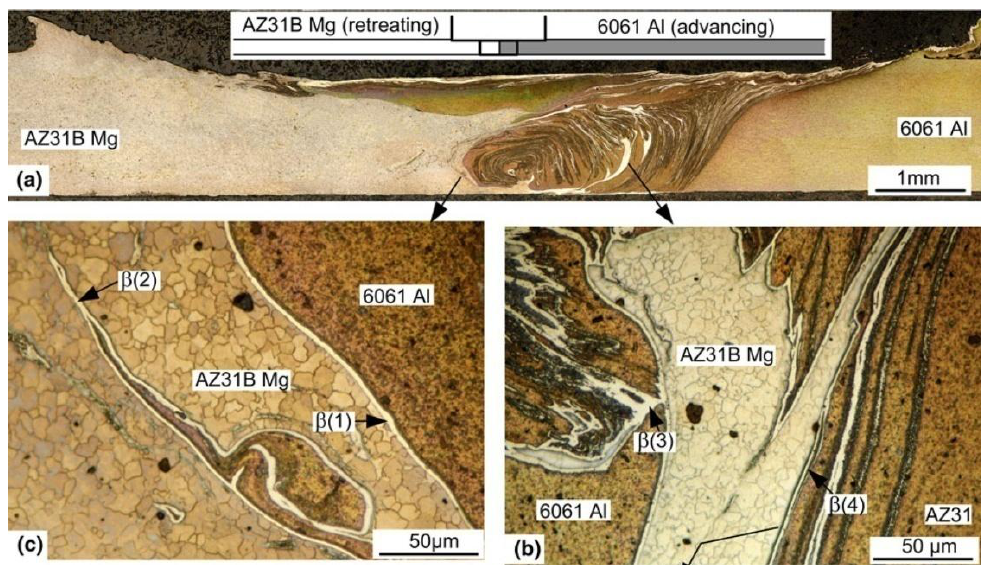
Figure 2. Macrostructures of friction stir welded Mg-Al joint [19]. ( a ) A transverse macrograph; ( b ) and ( c ) transverse micrographs showing Al